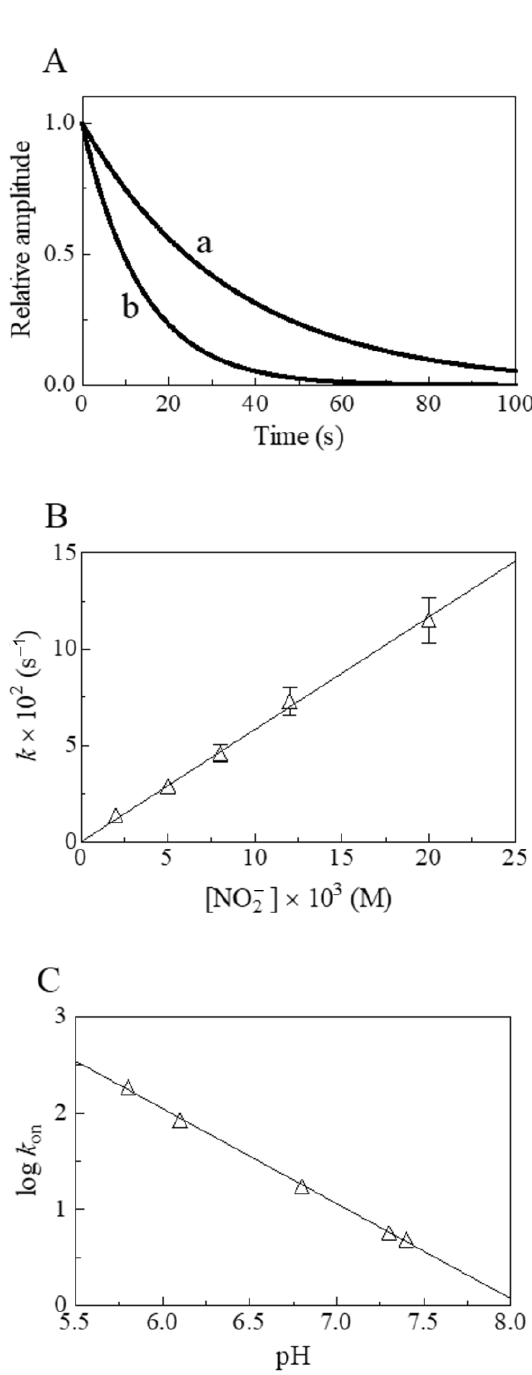
Figure 4. Nitrite reductase activity of Hs -Nb(II) at 20.0 ◦ C. ( A ) Normalized averaged time courses for the NO 2 − -mediated conversion of Hs -Nb(II) to Hs -Nb(II)-NO at pH 7.3 in the presence of 5.0 × 10 − 3 M (trace a) and 1.2 × 10 − 2 M (trace b) NO 2 − . The time course analysis according to Equation (3) allowed the determination of the following values of k obs : 2.9 × 10 − 2 s − 1 (trace a) and 7.3 × 10 −2 s −1 (trace b). ( B ) Dependence of k obs on the NO 2 − concentration for Hs -Nb(II) nitrosylation at pH 7.3. The solid line was calculated according to Equation (4) using k on = 5.8 ± 0.6 M −1 s −1 . ( C ) pH-dependence of log k on for the NO 2 − -mediated conversion of Hs -Nb(II)-NO. The value of the slope of the continuous line is −0.99 ± 0.10. Where not shown, standard deviation is smaller than the symbol.